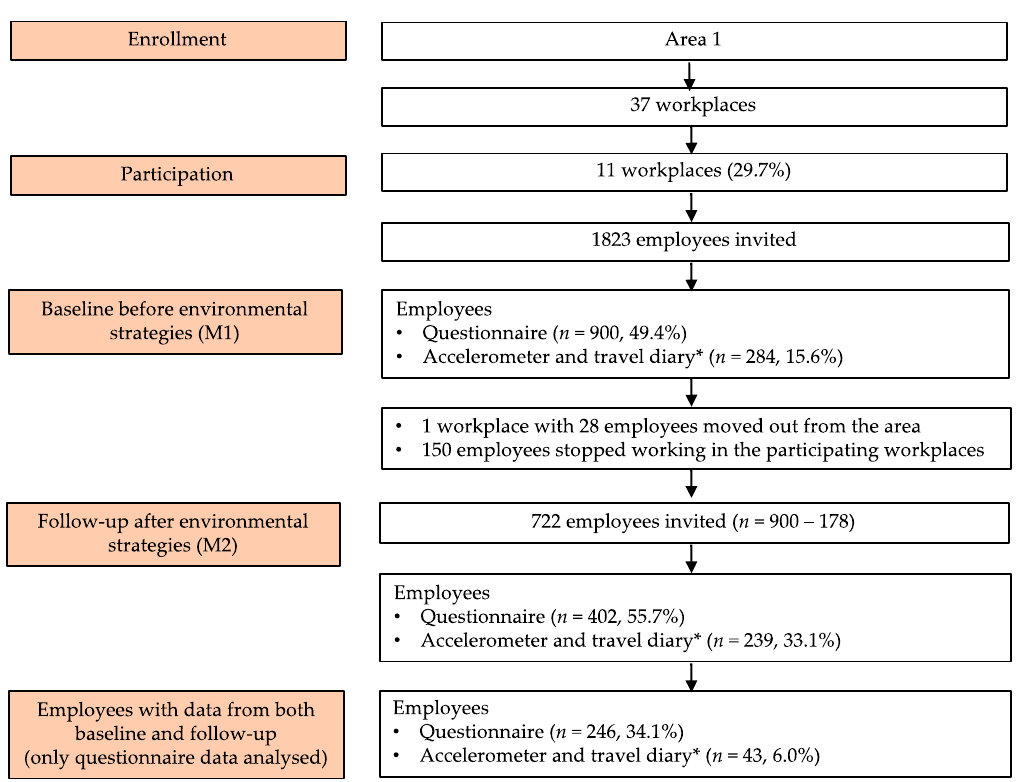
Figure 1. Flow chart of Phase 1 (workplaces in Area 1): Effects of improvements to walking and cycling paths in a longitudinal pre-post design.